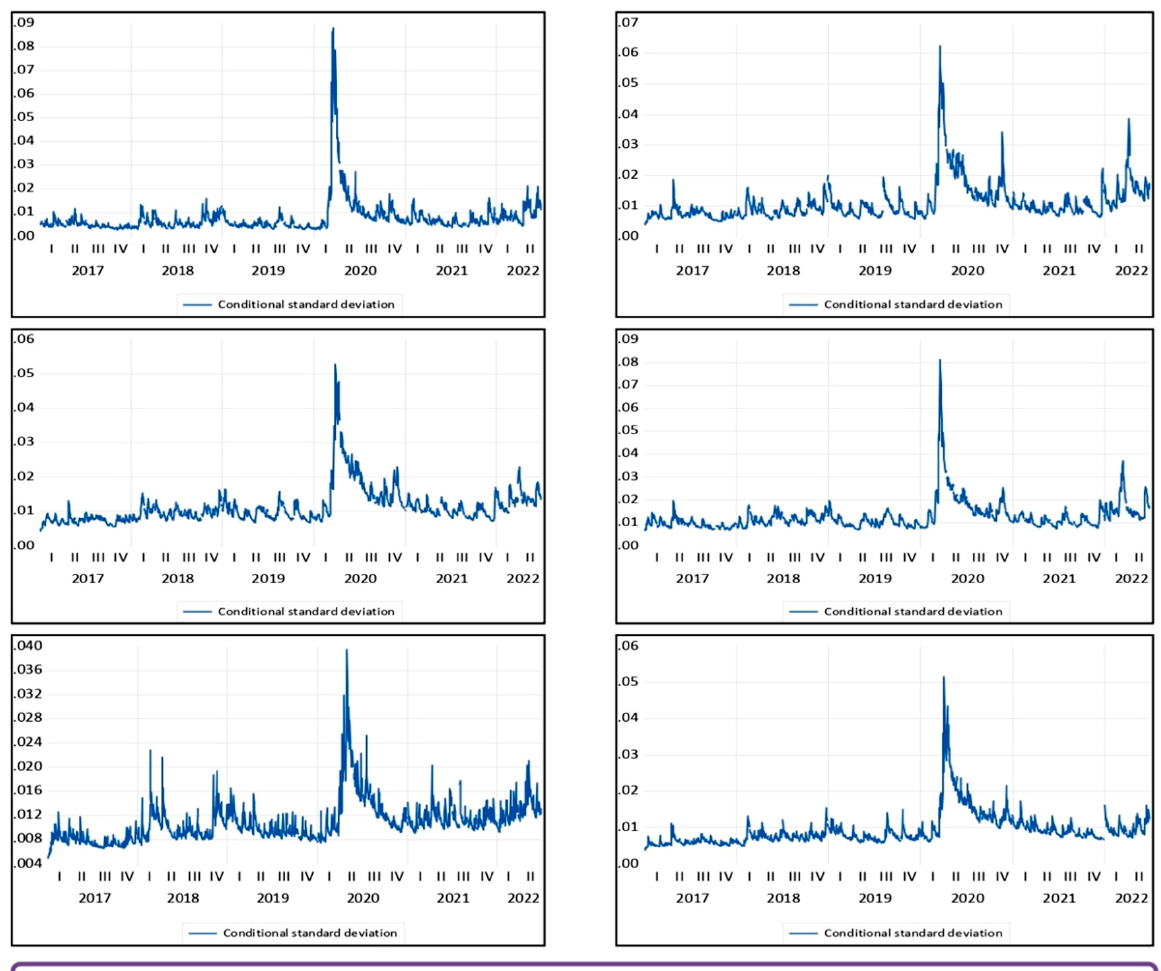
Figure 4. Graphical Representation of the variavles ( a ): TSX; ( b ): CAC 40; ( c ): DAX 30; ( d ): FTSE MIB; ( e ): NIKKEI 225; ( f ): FTSE 100 of G7 Countries under FIGARCH Estimation. Note: X axis measures time periods as represented by observations.